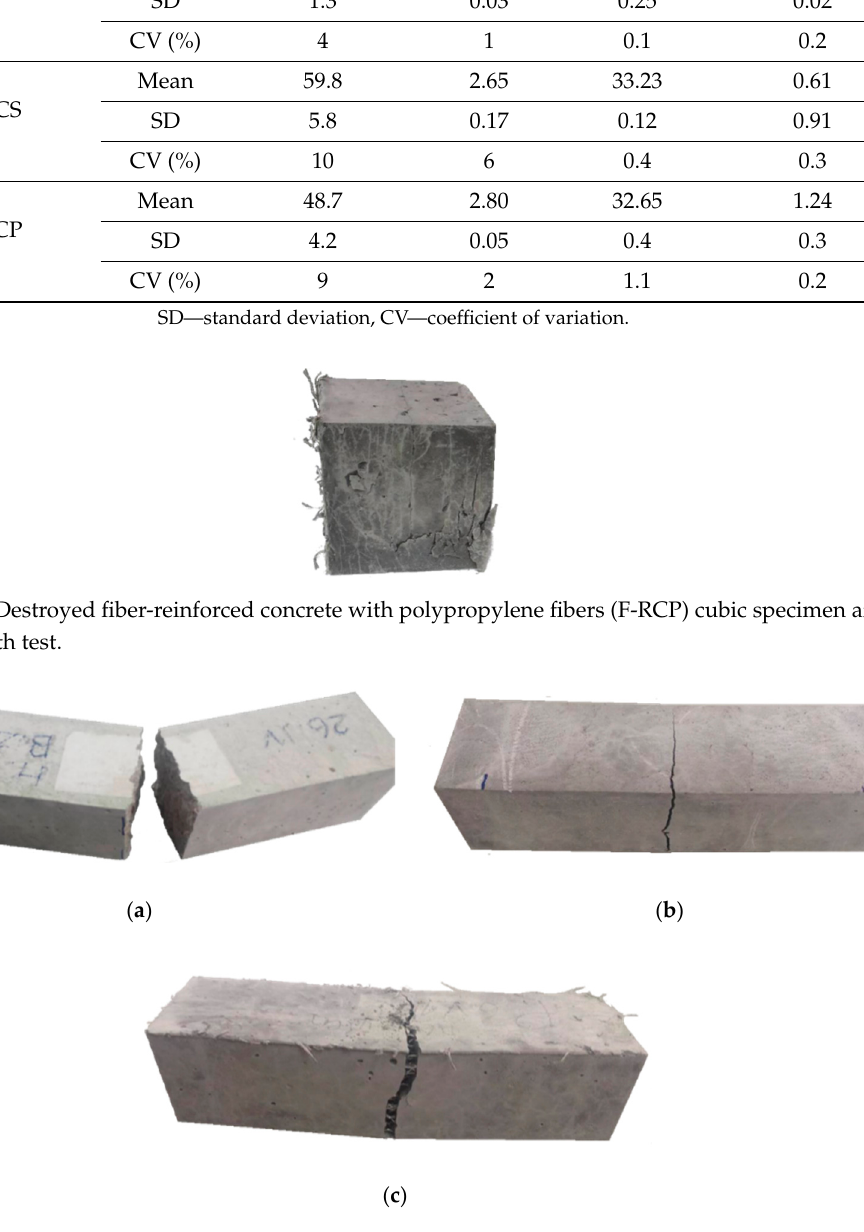
Figure 9. View of the destroyed sample after the flexural strength test: ( a ) reference concrete; ( b ) fiber-reinforced concrete with steel fibers and ( c ) fiber-reinforced concrete with polypropylene fibers.